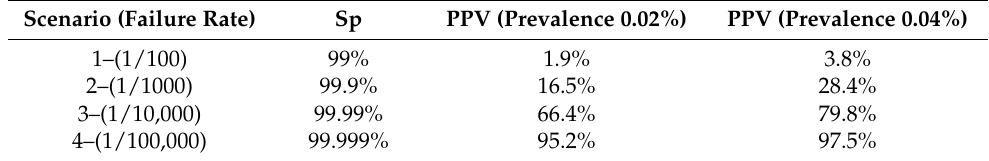
Table 6. Results of the four scenarios set to assess the positive predictive value (PPV) of the Salmonella routine testing in poultry breeding flocks in the Netherlands. The prevalences used are 0.02% and